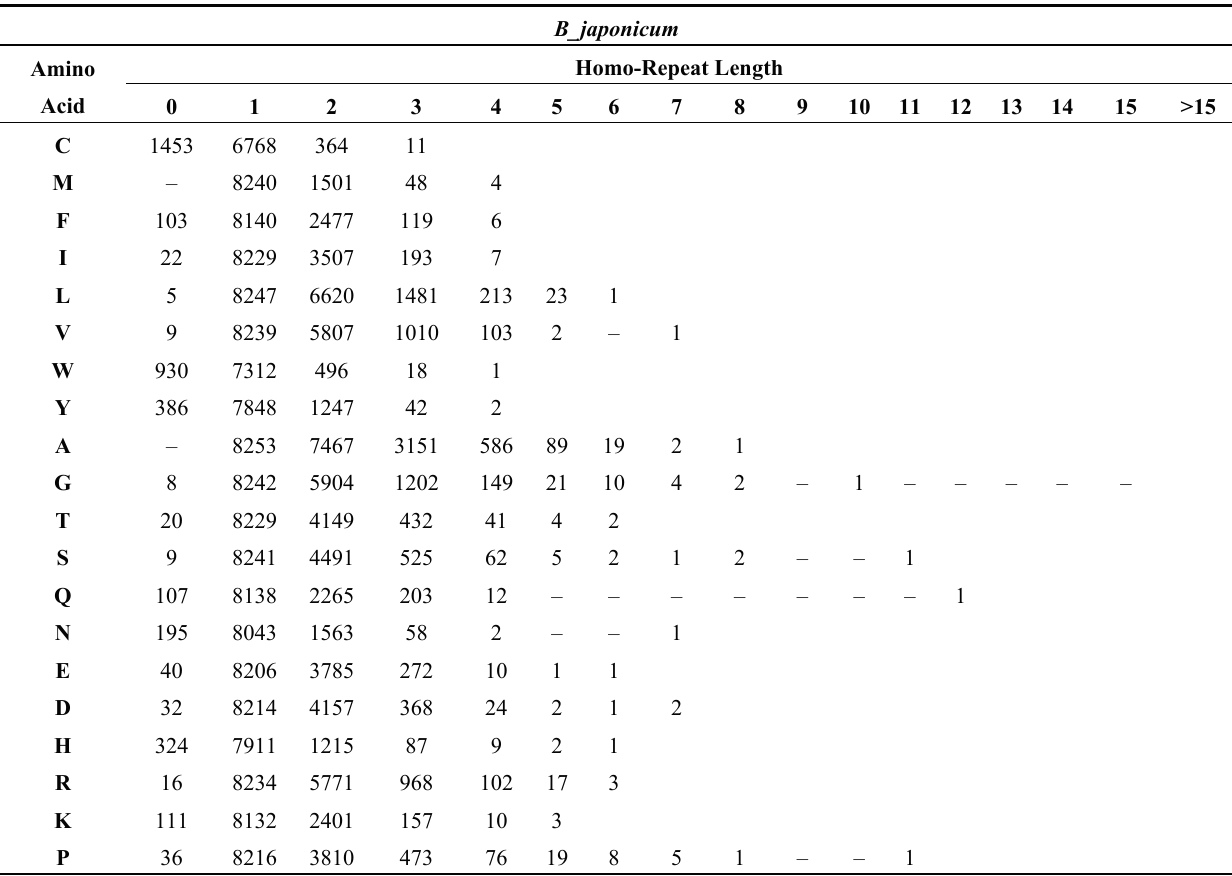
Table 1. Number of proteins with occurrence of homo-repeats of different lengths (up to 15 residues) for bacterial ( B_japonicum ) and eukaryotic ( H_sapiens )